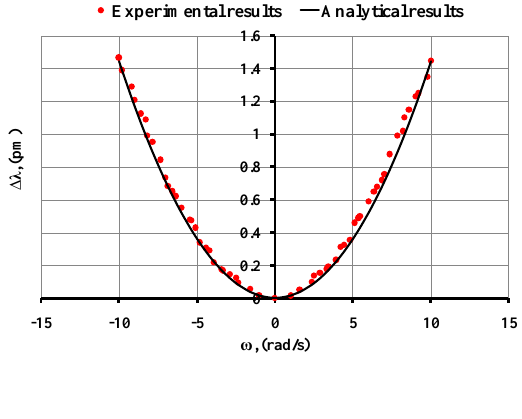
Figure 8. Comparison of experimental results with analytical prediction for a (60:1) PDMS